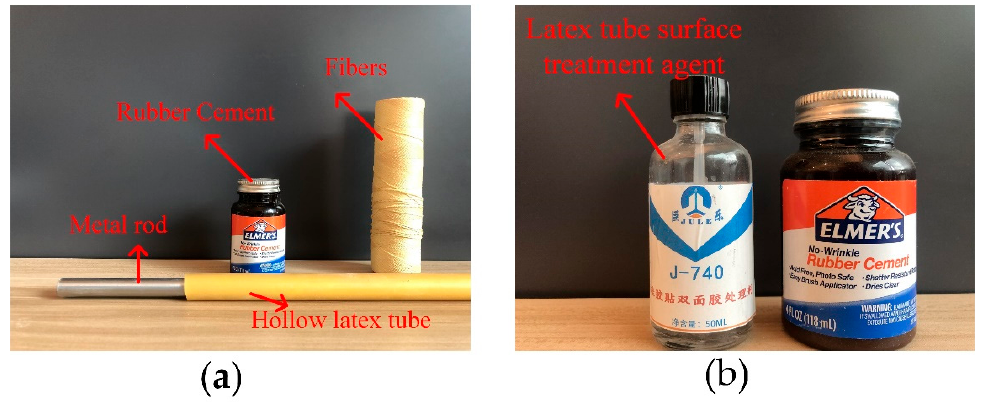
Figure 6. Materials used to fabricate soft actuator. ( a ) Materials of soft actuator manufacturing ( b ) Latex tube surface treatment agent.